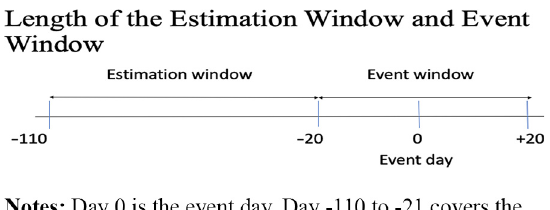
Figure 1. Event study